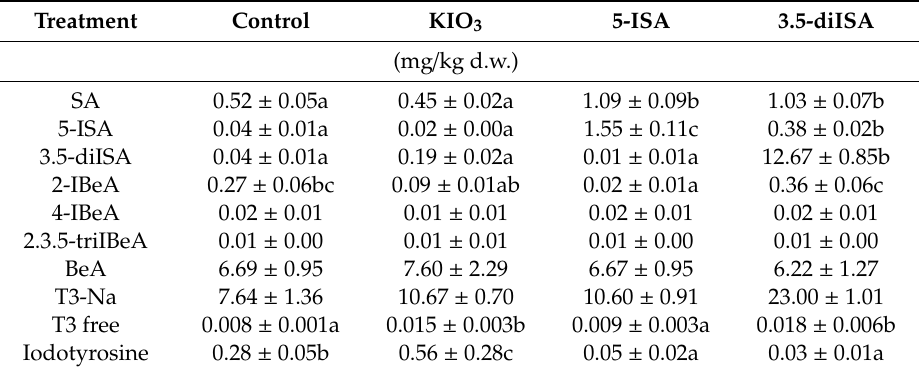
Table 6. The content of iodine compounds (means for